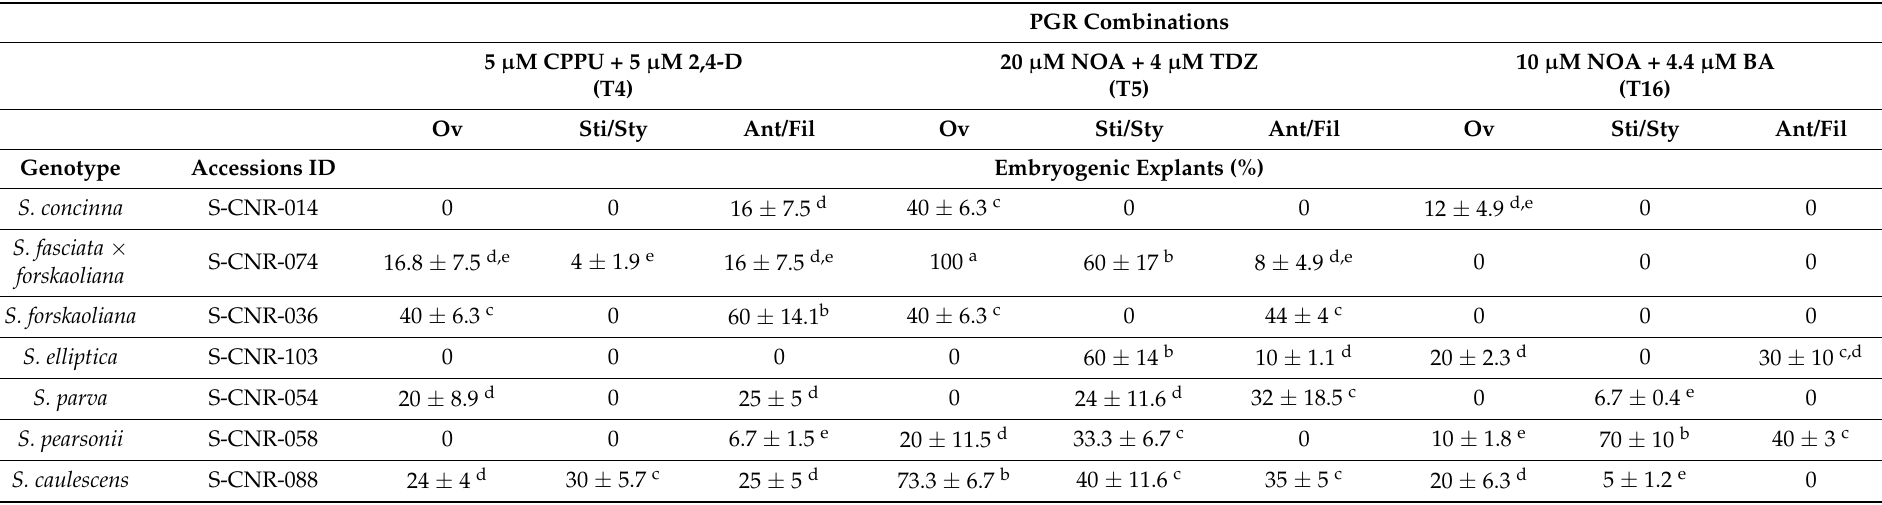
Table 2. Embryogenic response of seven Sansevieria genotypes using three explant types and three PGR combinations. Data were collected 6 months after culture initiation and each treatment comprised 300 explants for Ant/Fil and 50 explants for Ov and Sti/Sty. Means + SE, values followed by the same letter are not significantly different at p ≤ 0.05 level (Tukey’s